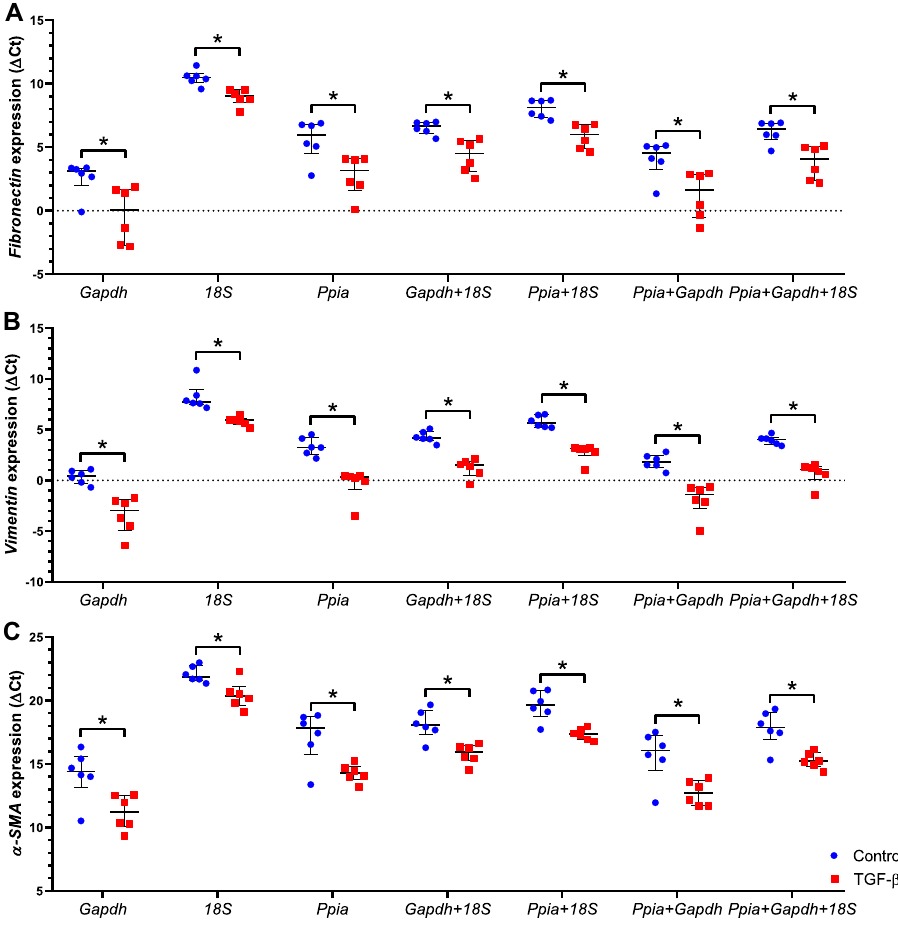
Figure 6. The ΔCt values of fibronectin ( A ), vimentin ( B ), and α-SMA ( C ) target genes normalized by different combinations of the three best candidate housekeeping genes ( Ppia , Gapdh, and 18S ). A negative ΔCt value indicates that the target gene is more abundant than the HKG. The median values are expressed as horizontal lines, and the error bars represent the interquartile range. p < 0.05 by Mann–Whitney U test: * vs control